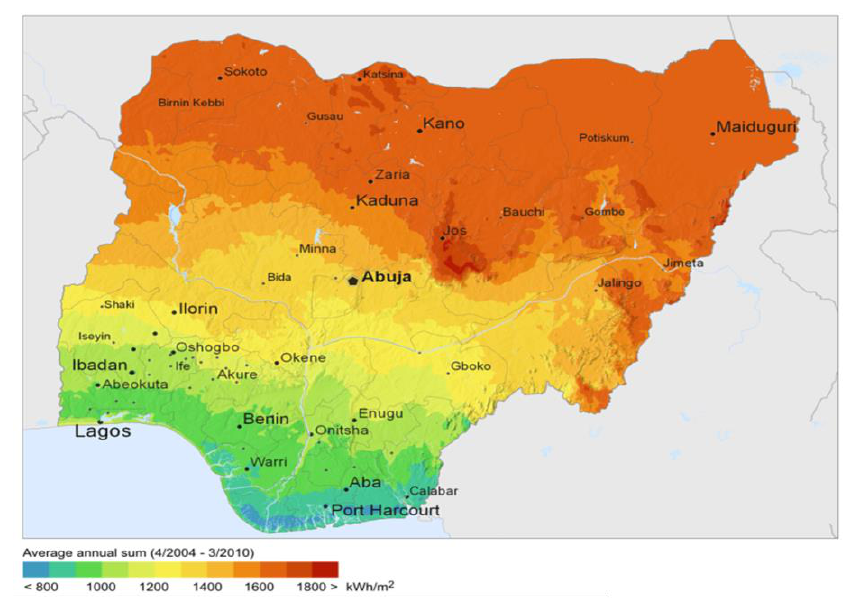
Fig. 3. Map of Nigeria showing radiation across regions. [28]